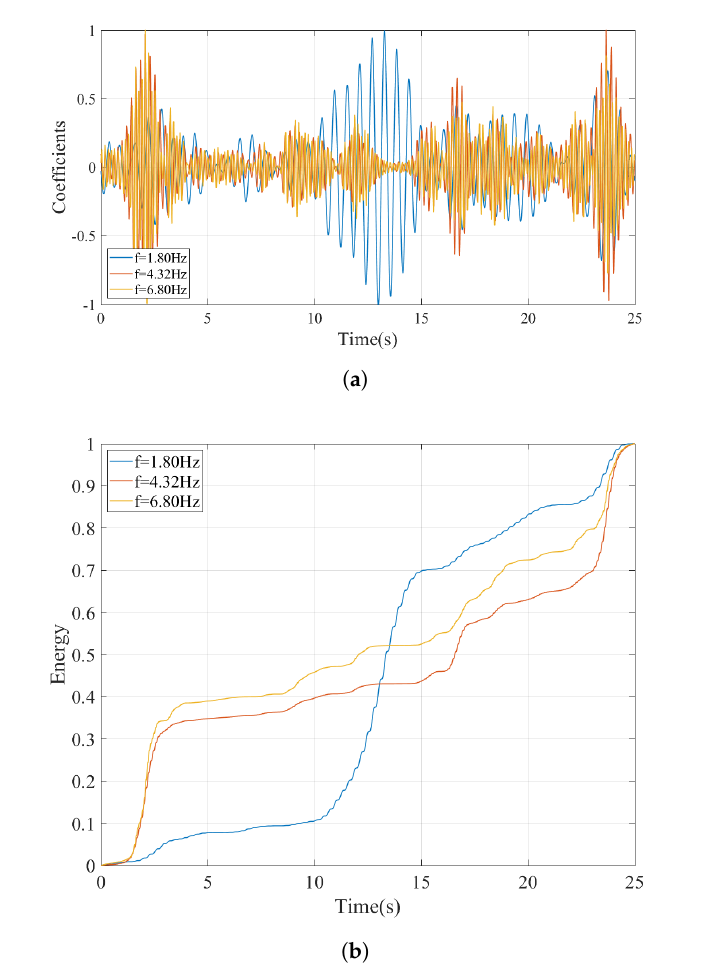
Figure 15. Irregular track (profile A) at a speed of 20 km/h. ( a ) Coefficients from CWT of the acceleration signal at different pseudo-frequencies. ( b ) Development of the energy in the coefficients at different